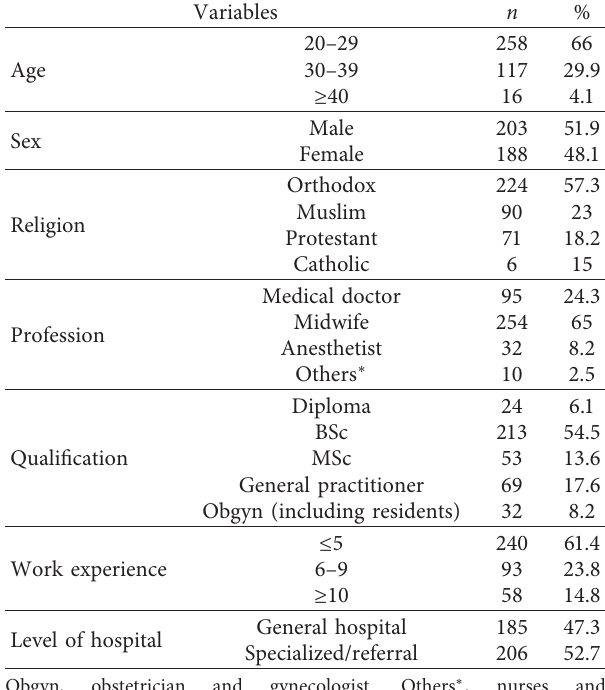
Table 1: Sociodemographic characteristics of obstetric care pro- viders working in labor and delivery in major public hospitals in Addis Ababa, Ethiopia, 2020 ( n � 391).